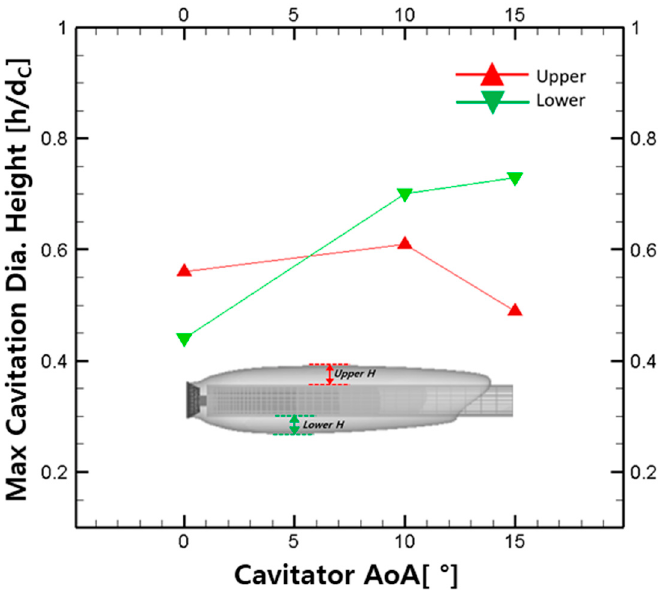
Figure 13. Comparison of maximum cavitation diameter for various cavitator angles of attack.